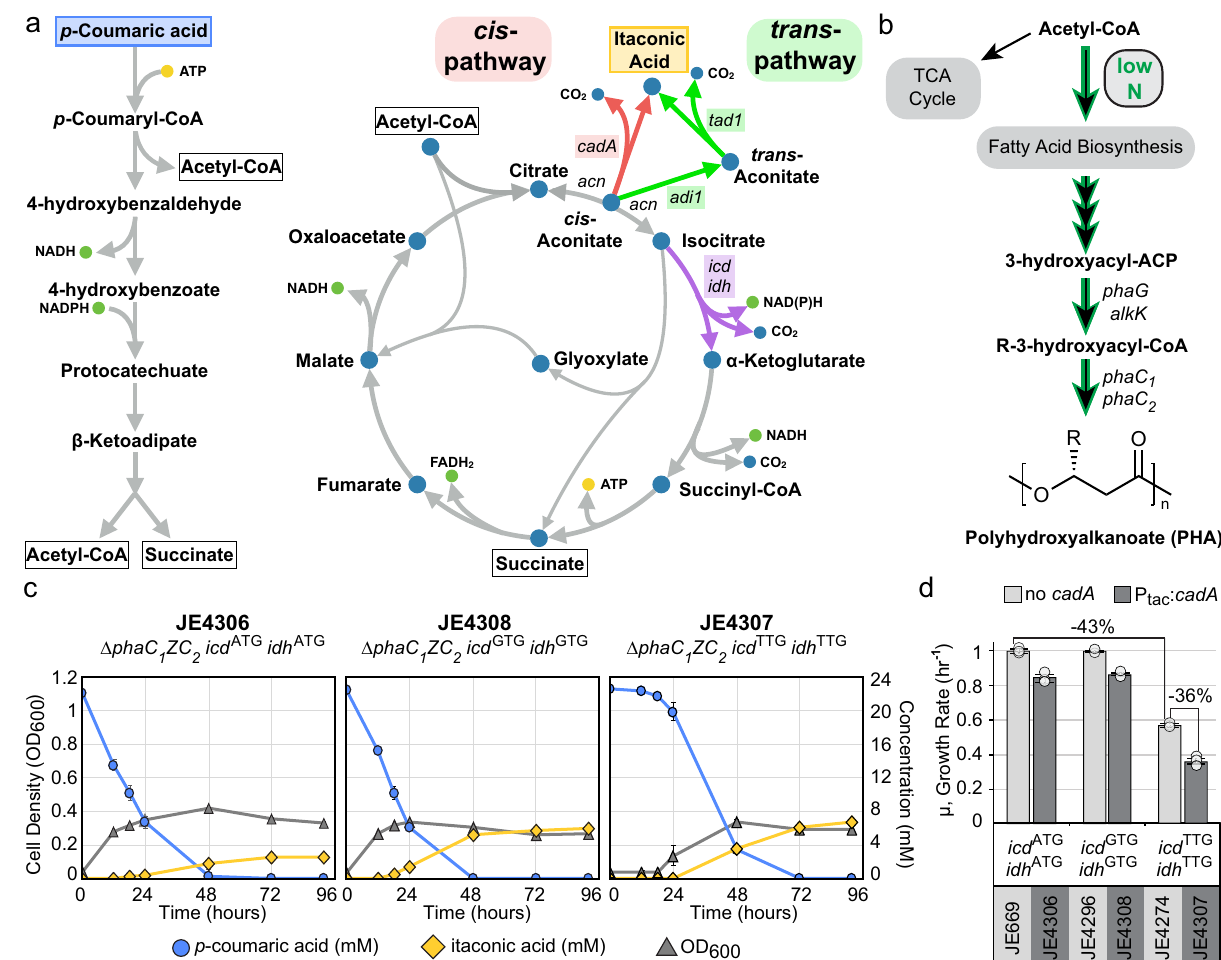
Fig. 2 Two-stage production of itaconic acid from p -coumaric acid. a Simpli fi ed p -coumaric acid assimilation, β -ketoadipate, and tricarboxylic acid (TCA) cycle pathways in Pseudomonas putida KT2440 with modi fi ed or heterologous steps indicated by colored arrows, and connecting metabolites outlined. For simplicity some steps are not included. The cis (red arrow) and trans (green arrow) pathways for itaconic acid are indicated with involved genes, cadA ( cis ) & tad1/adi1 ( trans ) adjacent to the reaction their gene products perform. Isocitrate dehydrogenase activity, provided by the icd & idh gene products, is indicated by a purple arrow. b Simpli fi ed polyhydroxyalkanoate (PHA) biosynthesis pathway in P. putida KT2440. The PHA pathway, via fatty acid